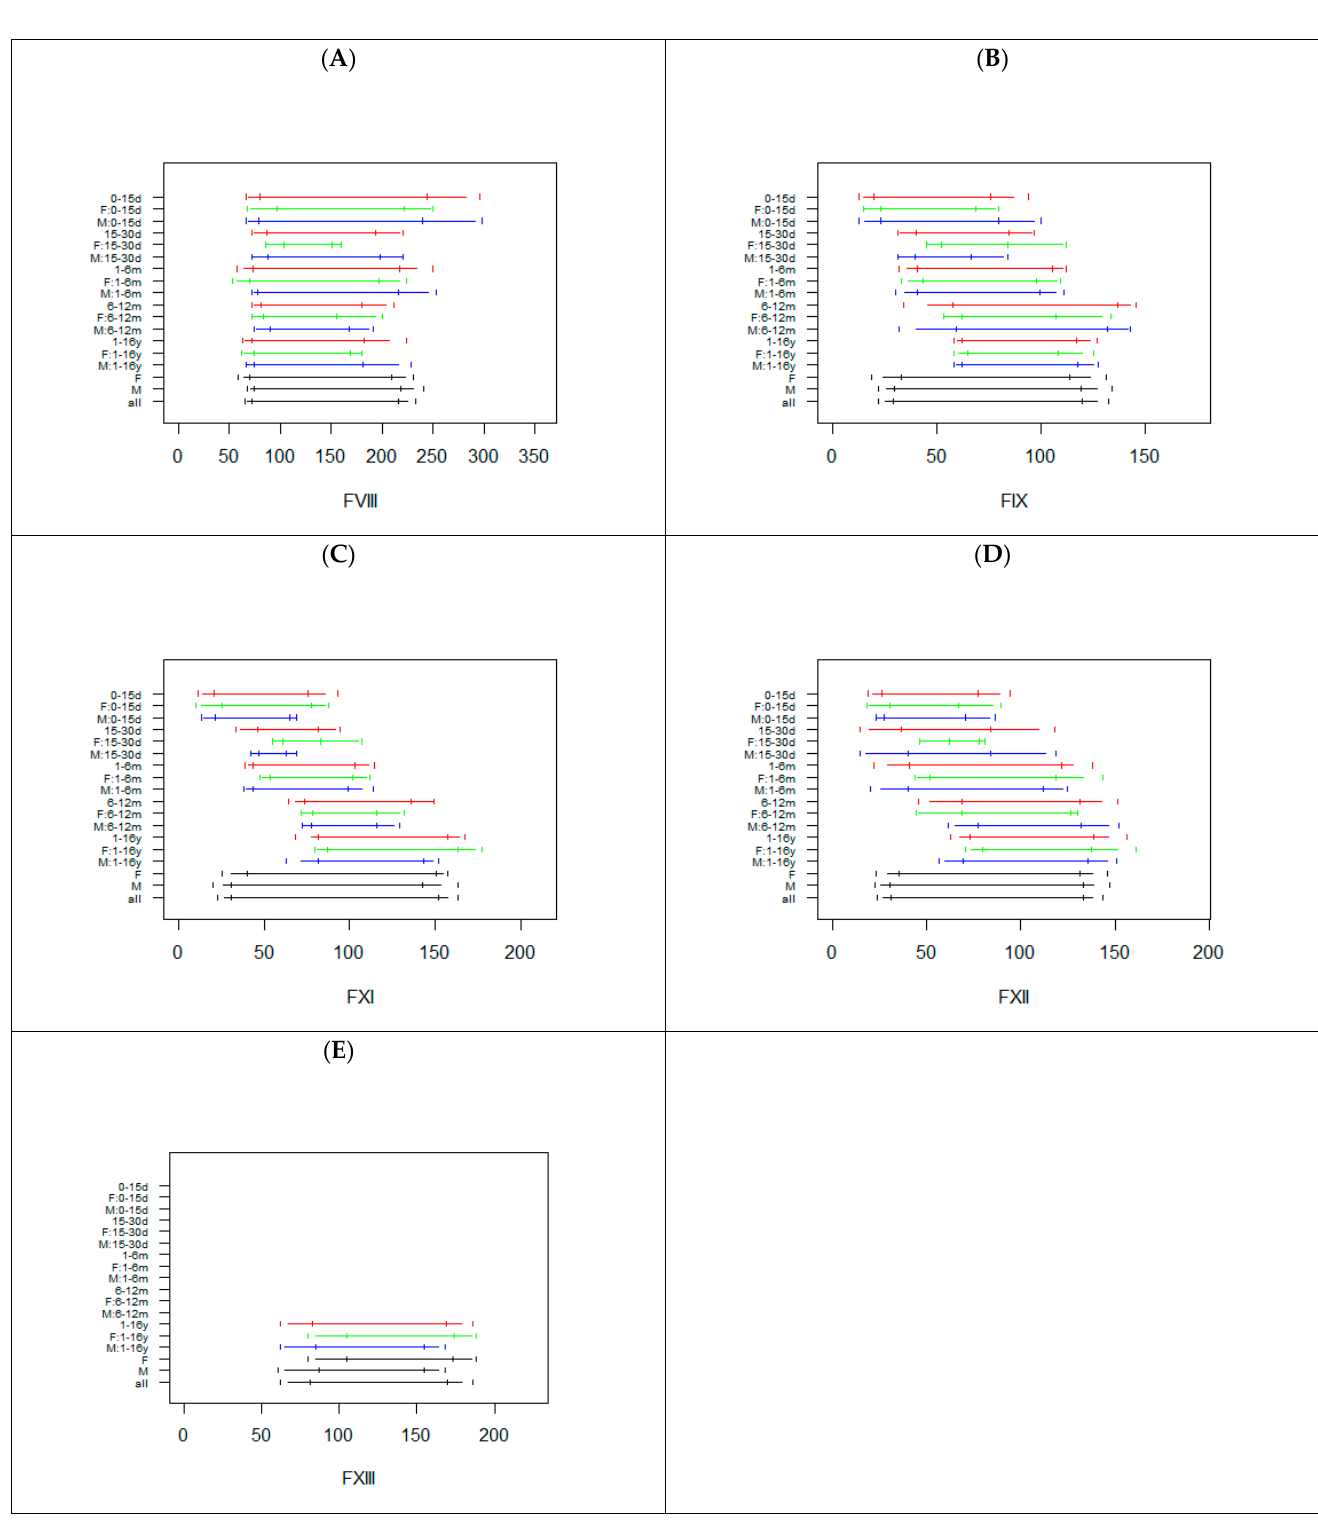
Figure 3. Reference intervals for FVIII ( A ), FIX ( B ), FXI ( C ), FXII ( D ), and FXIII ( E ) in the subjects subgrouped by sex and age. The horizontal segments represent the RIs, while the vertical segments indicate the limits of the 90% confidence interval of the RIs. For each class, RIs are reported combining males and females (red) or, respectively, only in females (green) or males (blue). The last three RIs are calculated, without taking into account age, in females, males, or in the whole sample. d = days, m = months, y = years, F = females, M =